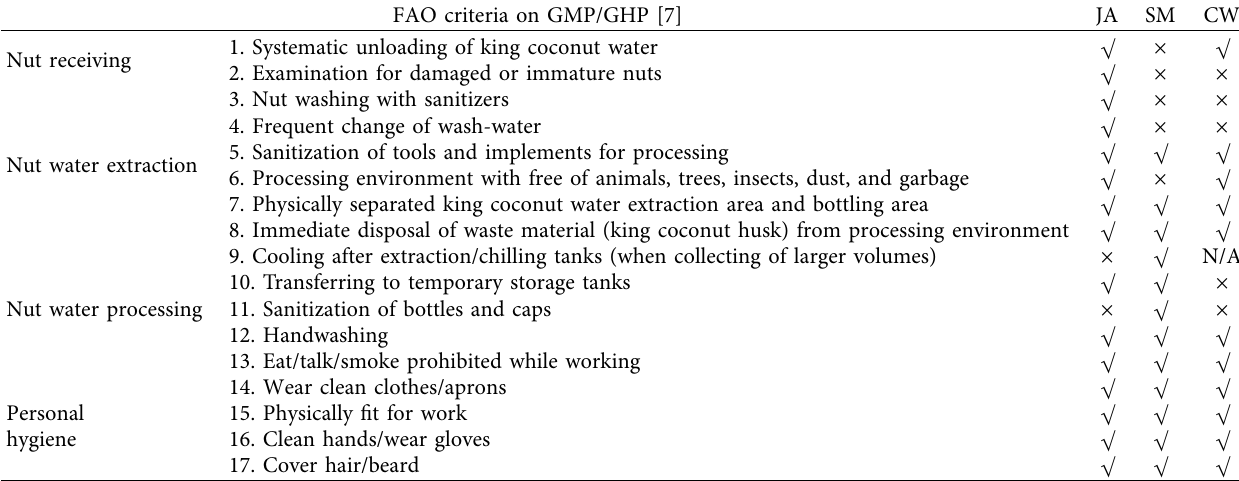
Table 1: Processing conditions observed at each processing facility during the facility